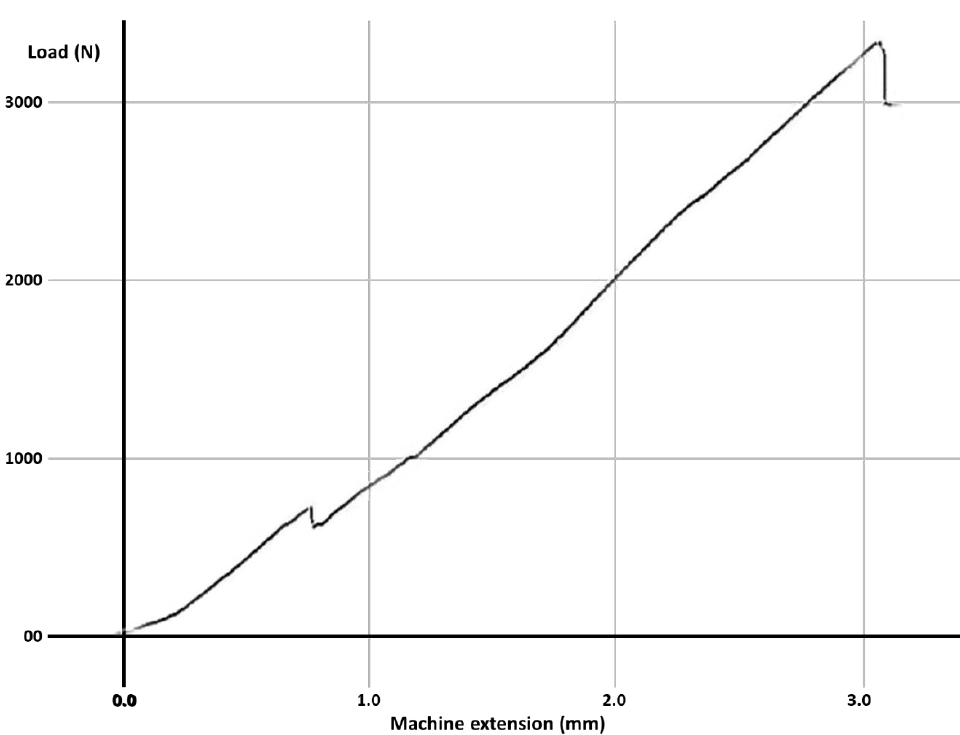
Materials 2021 , 14 , x FOR PEER REVIEW Figure 7. The maximum value of the force at which the most resistant molar from Group F failed.